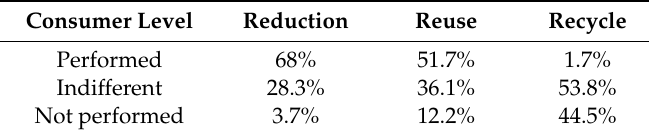
Table 6. Practice level of 3Rs based on consumer behavior.